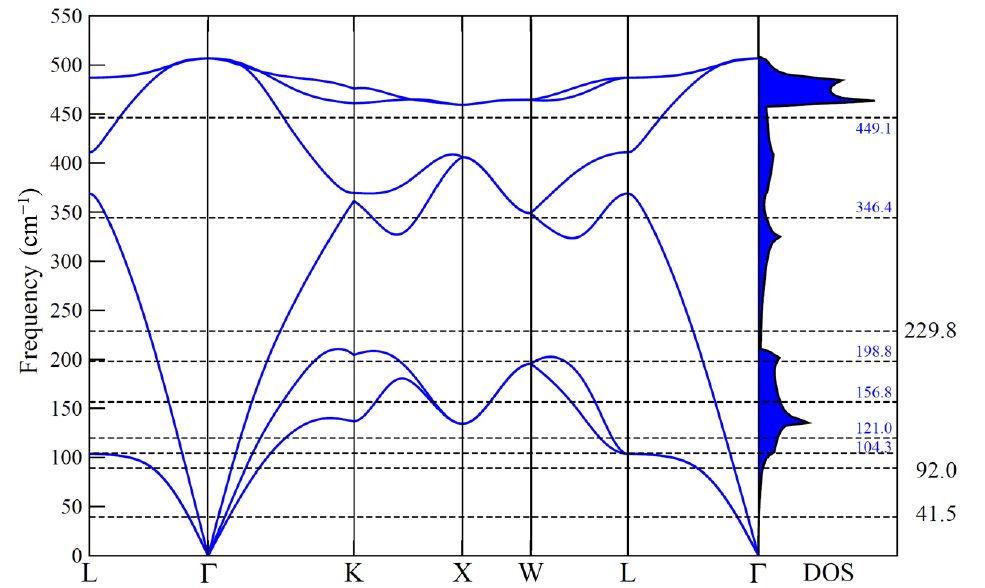
Figure 3. DFT-PBEsol calculated phonon dispersion (left hand side) and phonon density of states (right hand side) of bulk Si. The measured Raman frequencies (in parallel polarization) are repre- sented as dashed horizontal